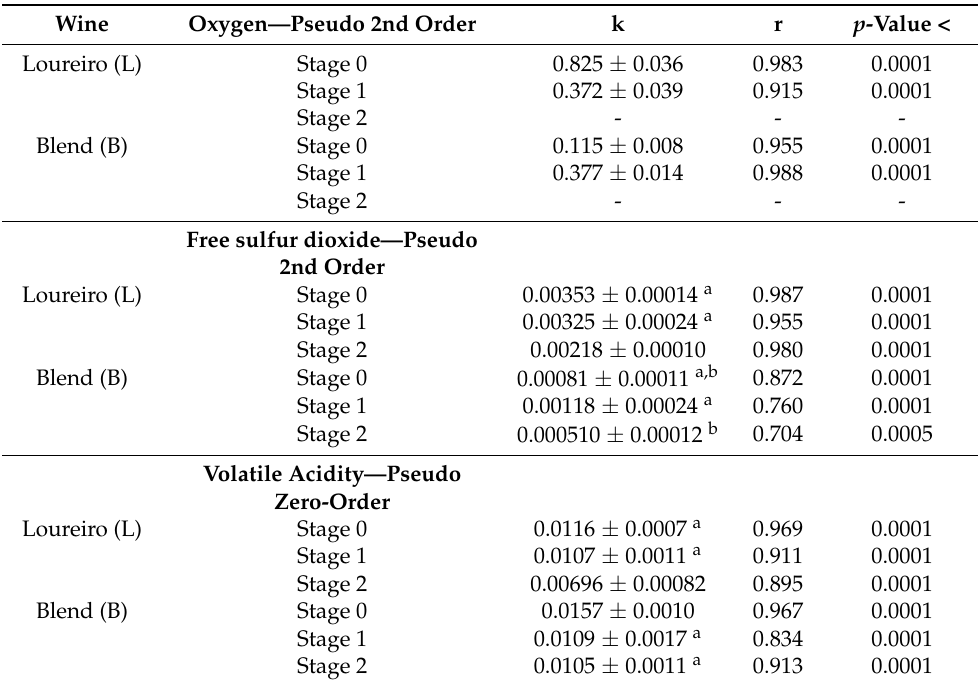
Table 2. Kinetic model for dissolved oxygen, sulfur dioxide, and volatile acidity of the Loureiro monovarietal wine and Blend wine before and after transport.